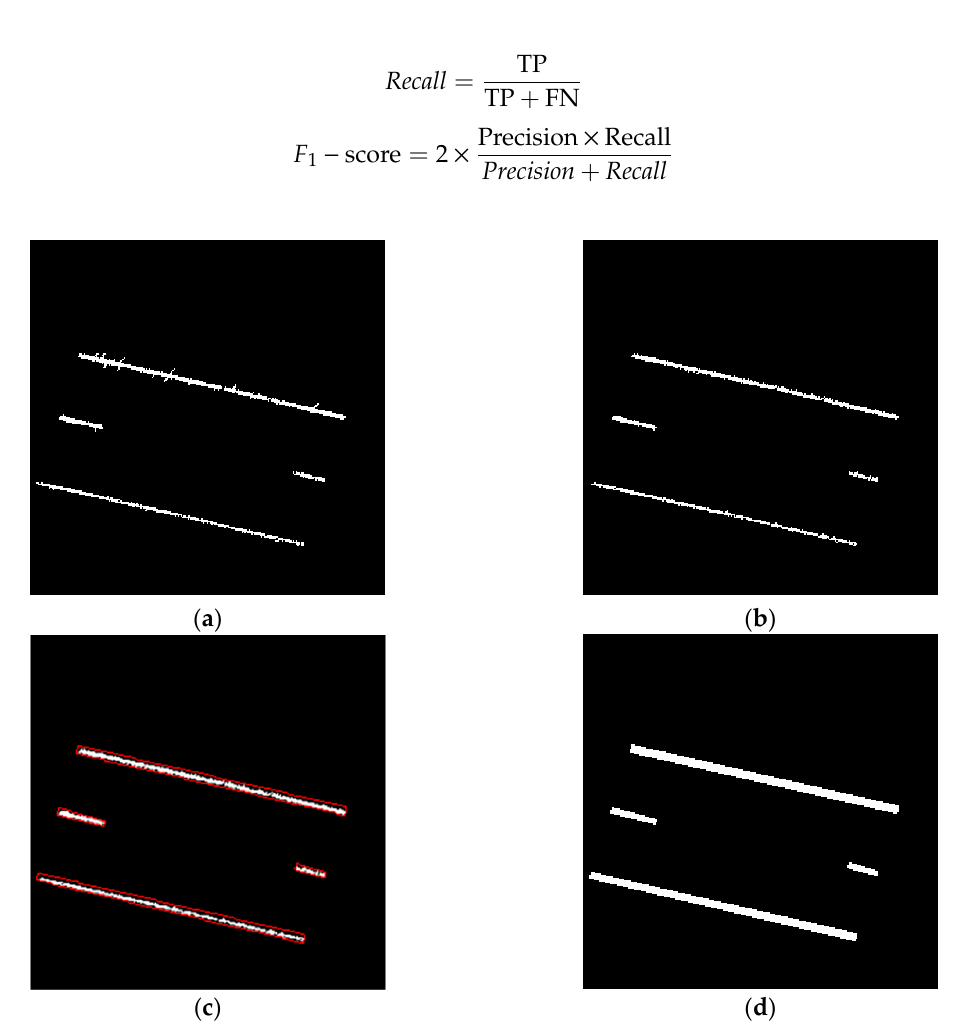
Figure 11. Illustrations of derived lane markings from ( a ) normalized intensity thresholding, ( b ) normalized intensity thresholding after noise removal, ( c ) bounding boxes (in red) encompassing lane markings, and ( d ) labeled image.